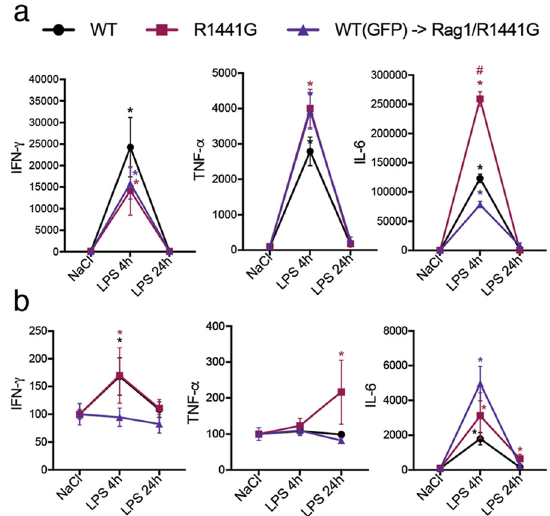
Fig. 3 LPS-induced activation of systemic IL-6 in double mutant chimeras is back to the WT level. Cytokines pro fi le in the serum ( a ) and SN ( b ) of WT, R1441G, and double mutant chimeras at 4 – 24 h after LPS injection. Data are mean ± SEM, n = 5 – 11. * p < 0.05 vs NaCl or vs group indicated on the graph.